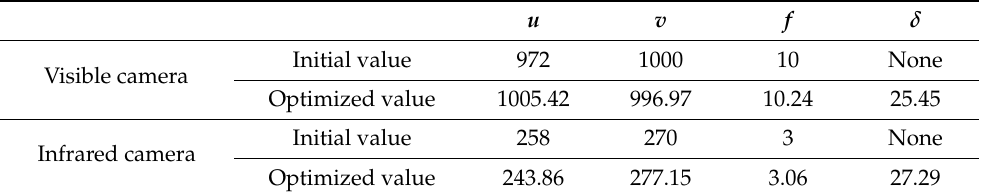
Table 1. Estimated geometric imaging parameters of the visible and infrared binocular all-sky-view cameras of the ASC-200 instrument. The units are in pixels for zenith coordinates u and v , in pixels per degree for focal length f , and in degrees for rotation angle δ .